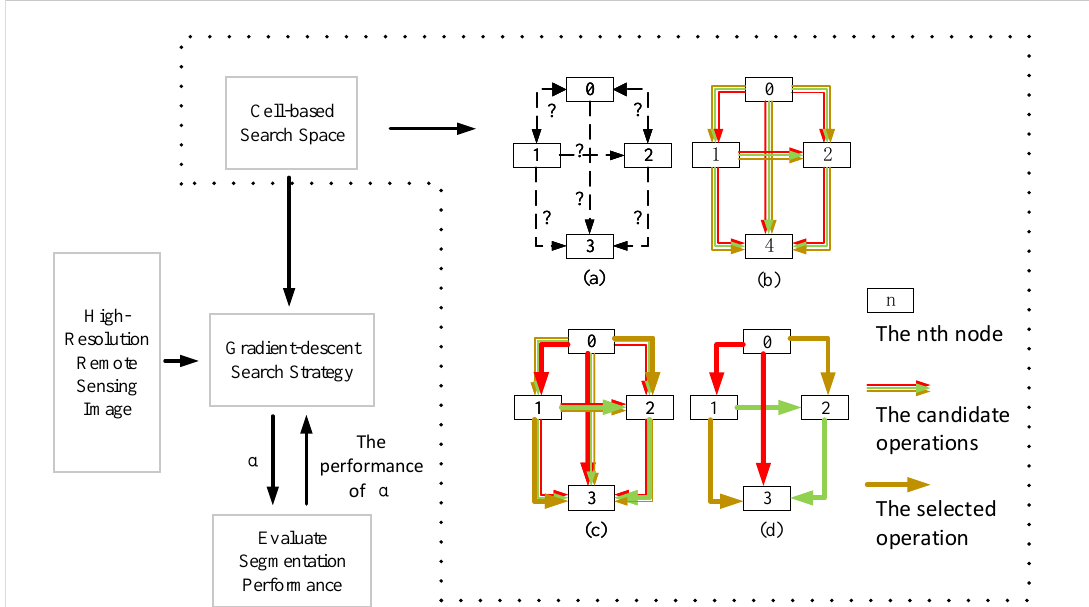
Figure 3. NAS-HRIS used the gradient descent search strategy to search the architecture of encoder in the cell-based search space and optimized the parameters by continuously evaluating the performance of the architecture. ( a ) operation of each edge in DAG is unknown; ( b ) candidate operations on each edge to continuous relaxation of the search space are set; ( c , d ) each edge is finalized by applying the reparameterization trick to sampling.